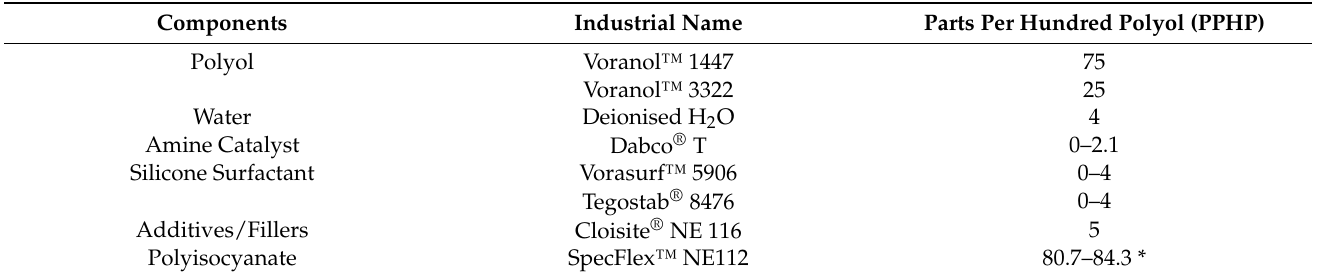
Table 2. Polyurethane formulation for experiments, only the concentration of the amine catalyst and silicone surfactants are varied.